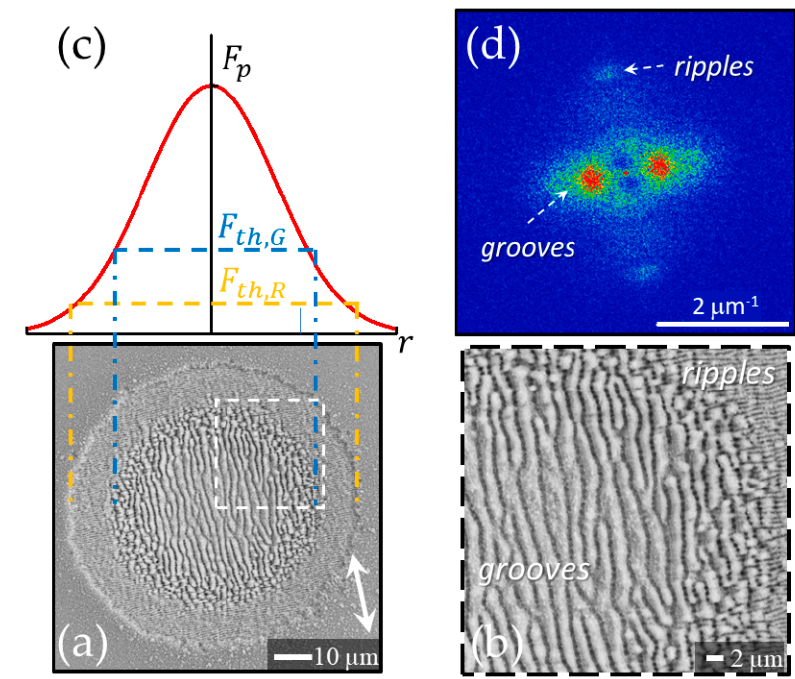
Figure 2. The SEM image in panel ( a ) shows a typical example of surface structures generated on a silicon surface after the irradiation with a Gaussian beam. The double-headed arrow in the SEM image of panel ( a ) shows the direction of the laser beam polarization. Panel ( b ) shows a zoomed view of the area in the white box evidencing the ripples aligned normal to the direction of laser polarization and the micro-grooves oriented along the polarization direction, respectively. Panel ( c ) displays the fluence spatial profile of the Gaussian laser beam and the threshold fluences for the generation of ripples and grooves, respectively. Panel ( d ) shows the 2D-FFT map of the SEM image of panel ( a ) with the characteristic signature of ripples and grooves. The SEM image refers to an irradiation sequence of N = 200 laser pulses with ≈ 35 fs duration at a wavelength of 800 nm for a peak fluence of about 0.7 J/cm 2